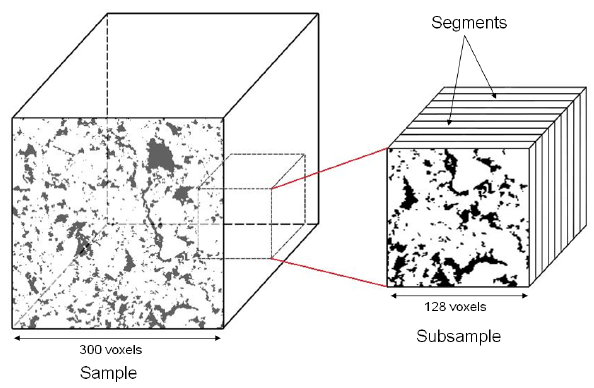
Fig. 1. 3-D spatial arrangement of the data structure. Treatments were compared by comparing physical properties for cubed sam- ples. Within each sample, subsamples were selected, which were di- vided in segments to enable quantification of fungal invasion. Fun- gal invasion was initiated from the first segment in each